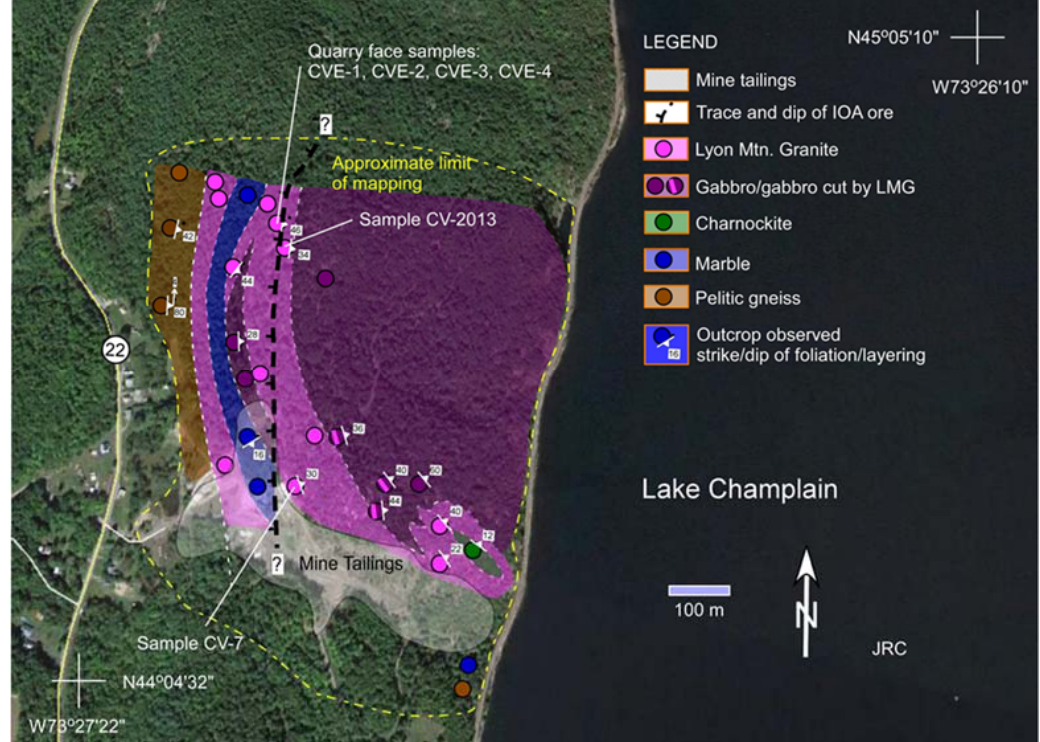
Figure 4. Geologic map of the area surrounding the Cheever Mine near Port Henry, NY. Satellite imagery from Google Earth.